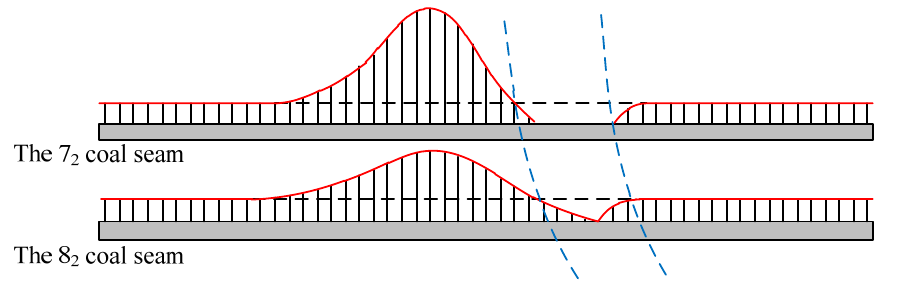
Figure 4. Stress distribution of the protected coal seam.